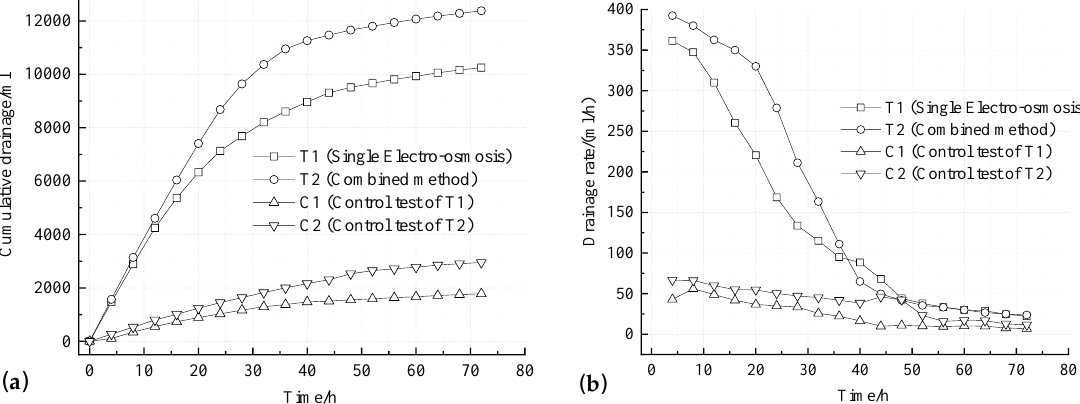
Figure 4. The development of the drainage with time: ( a ) The cumulative discharge; ( b ) The drainage rates.